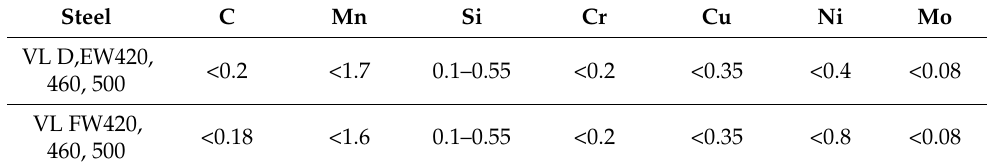
Table 2. Chemical composition of steels according to DNVGL-OS-B101, wt%.